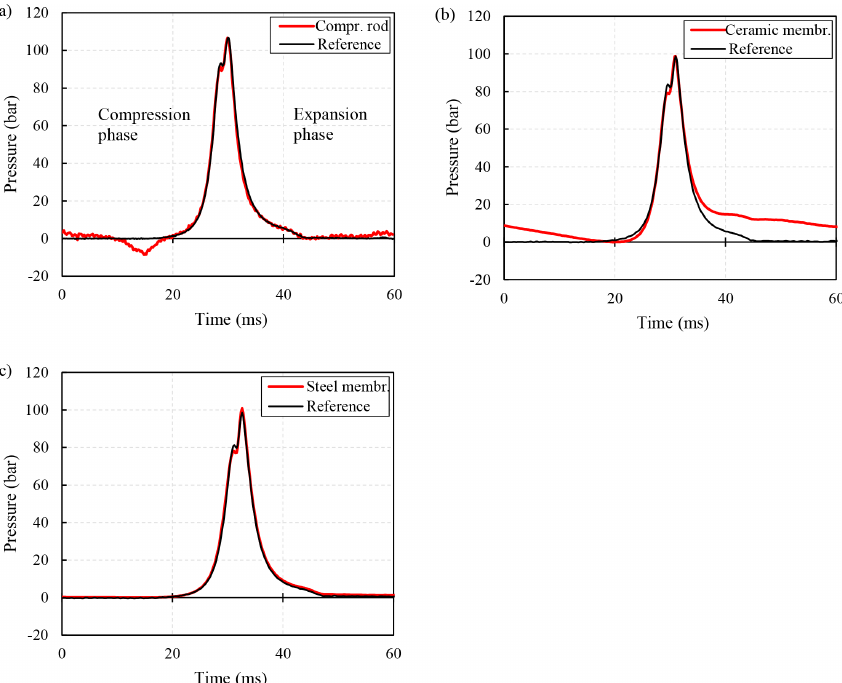
Figure 8. Time-resolved pressure curves of one exemplary combustion cycle for each sensor concept ( a force compression rod, b ceramic membrane type, c steel membrane type). The data were recorded at 1900rpm and 150Nm torque of the diesel